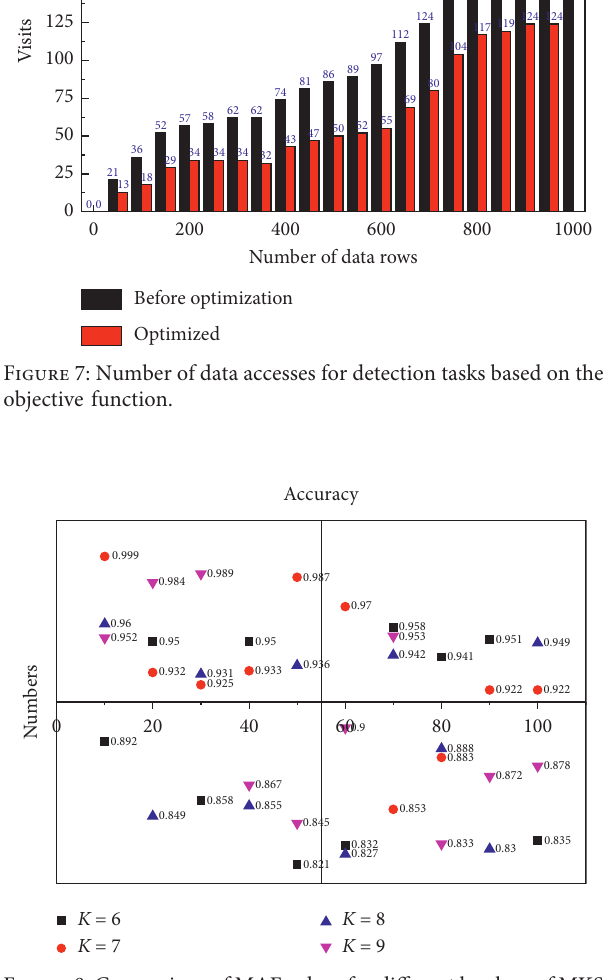
Figure 8: Comparison of MAE values for different k values of MKS algorithm.